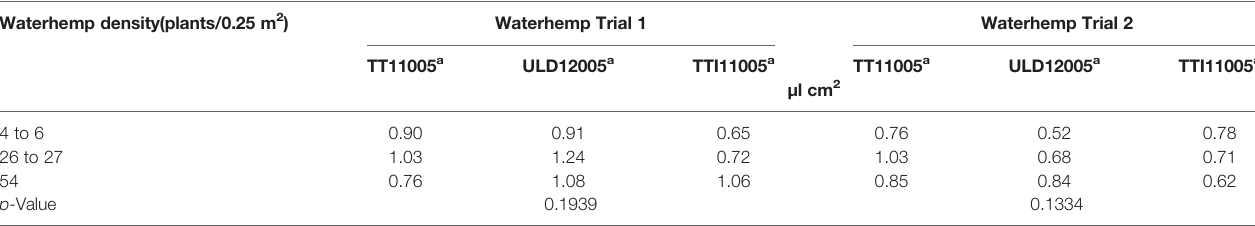
TABLE 5 | Herbicide solution deposition onto waterhemp plants as in fl uenced by waterhemp density and nozzle type. Waterhemp density(plants/0.25 m 2 )